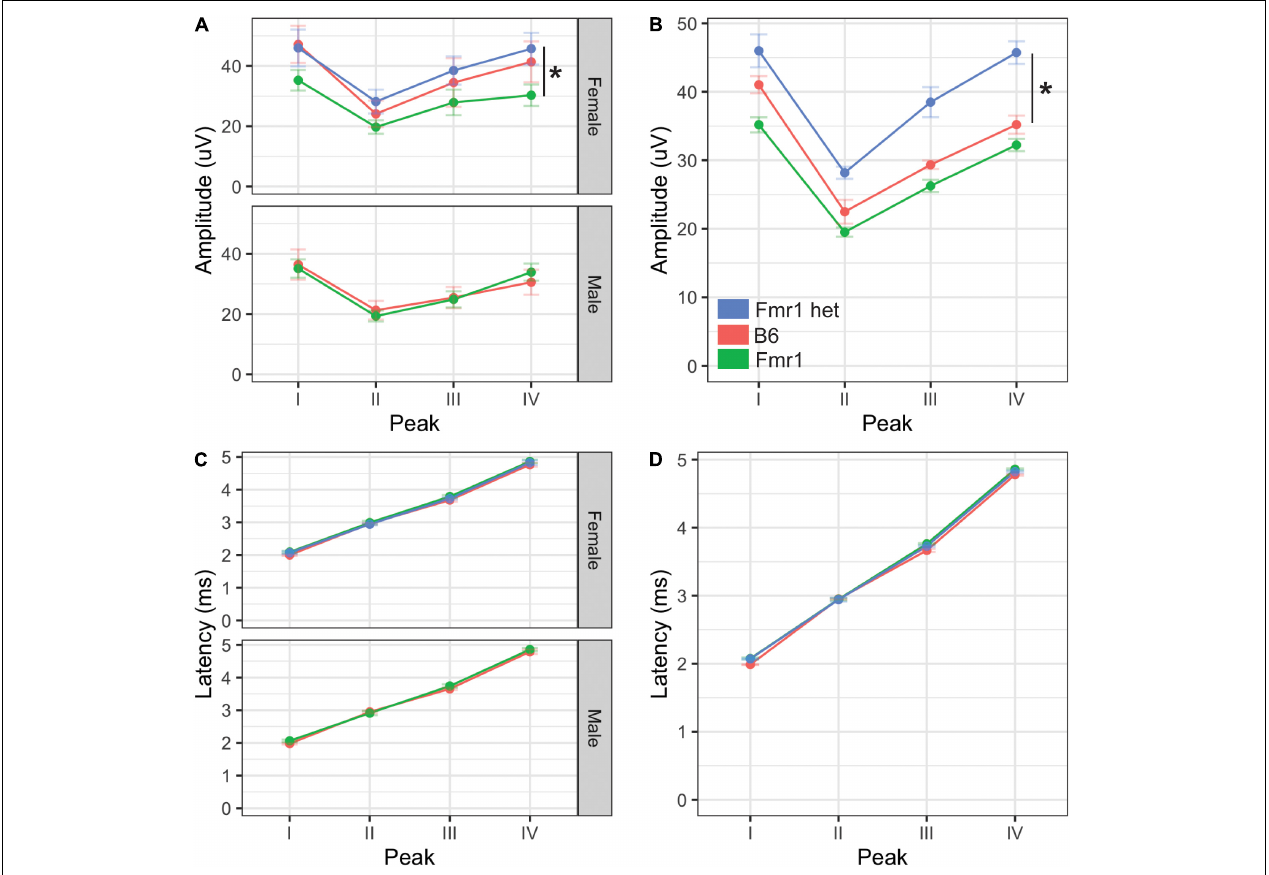
FIGURE 4 | Monaural hearing in mice with FXS. Monaural amplitudes and latencies for peaks I–IV of the ABR were recorded for Fmr1, Fmr1 het, and B6 animals. Peak IV amplitude was significantly lower in Fmr1 mice females compared with Fmr1 het females ( A , upper). There were no significant differences in amplitudes for males ( A , lower). When combined, there was a significant difference in Fmr1 het animals compared with Fmr1 (B) . There was no difference in latency of peaks I–IV between sexes (C) or genotypes (D) . * p < 0.05. Data represent 6 B6, 12 Fmr1, and 9 Fmr1 het females and 8 B6 and 14 Fmr1